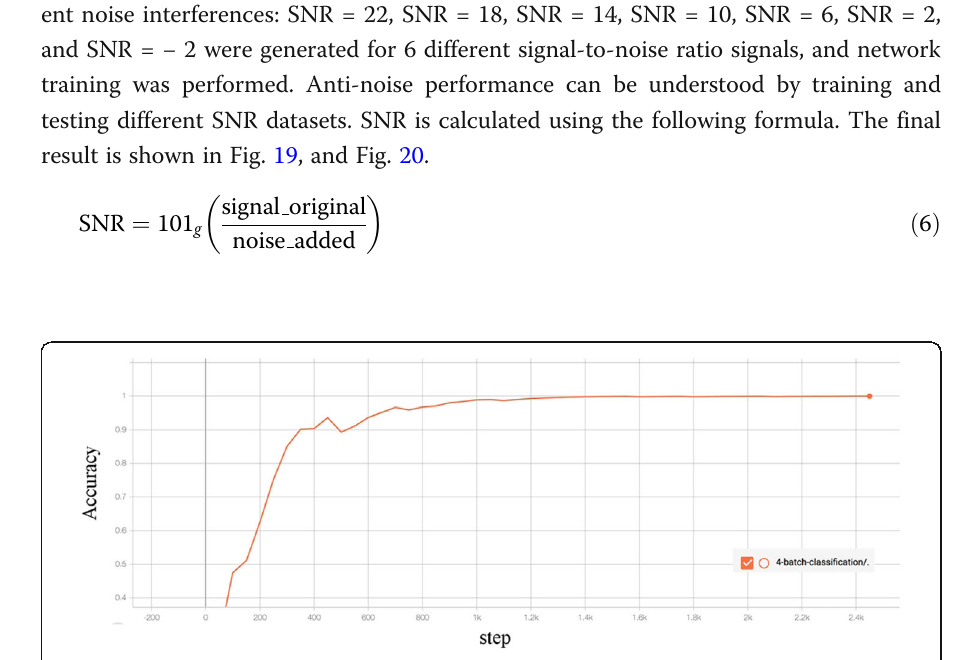
Fig. 17 Training accuracy of classification into 4